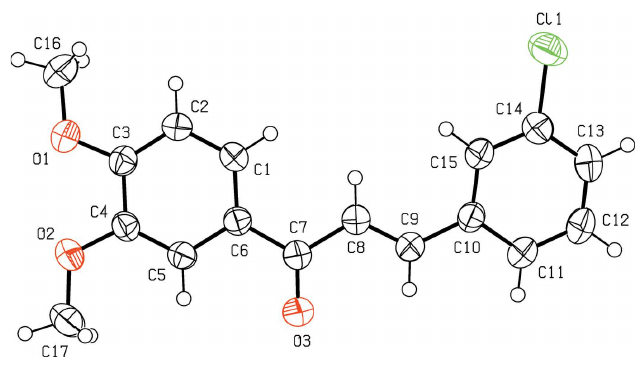
Figure 1 The molecular structure of the title compound, showing the atom labelling and displacement ellipsoids drawn at the 50% probability level.